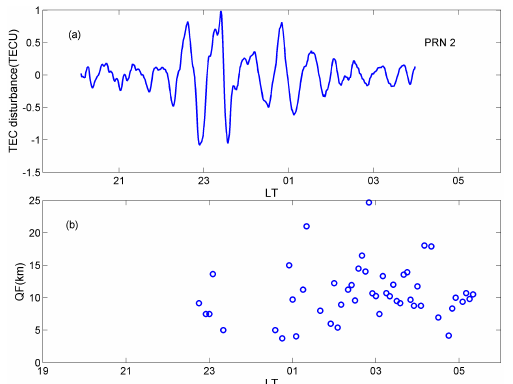
Figure 7. Local time variations of (a) TEC perturbations and of (b) QF obtained on 23 June 2012 over Sanya.